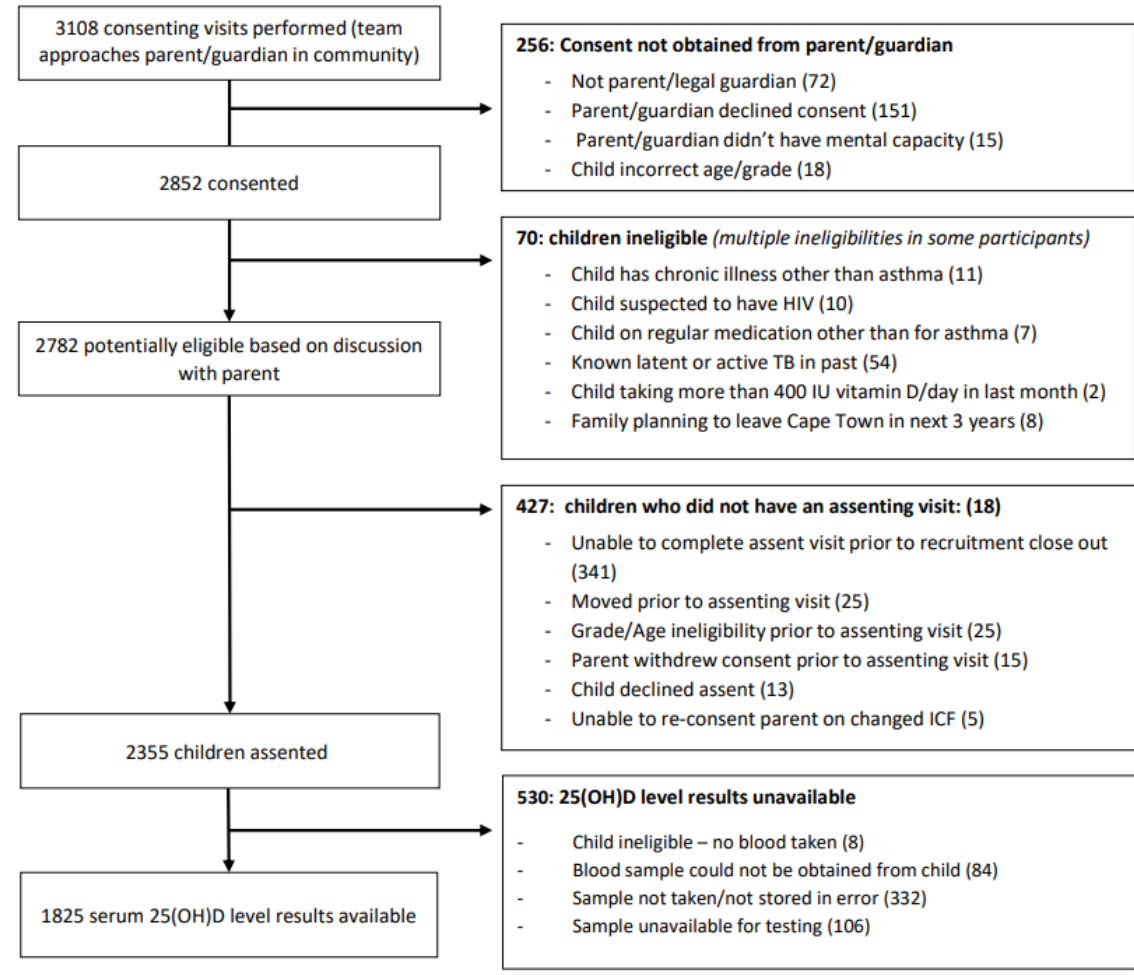
Figure 1. Consort diagram for screening and enrolment. Table 1. Determinants of mean 25(OH)D concentration: univariate and multiple linear regression